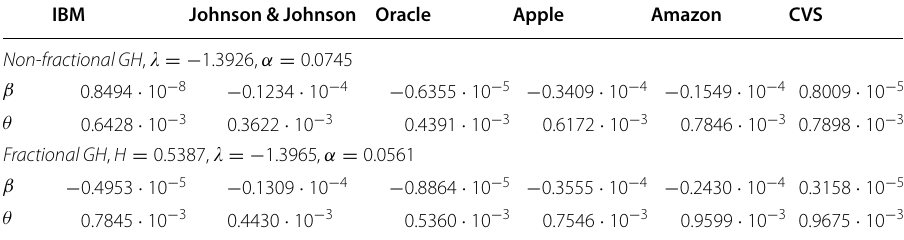
Table 3 Estimated parameters of non-fractional GH and fractional GH process